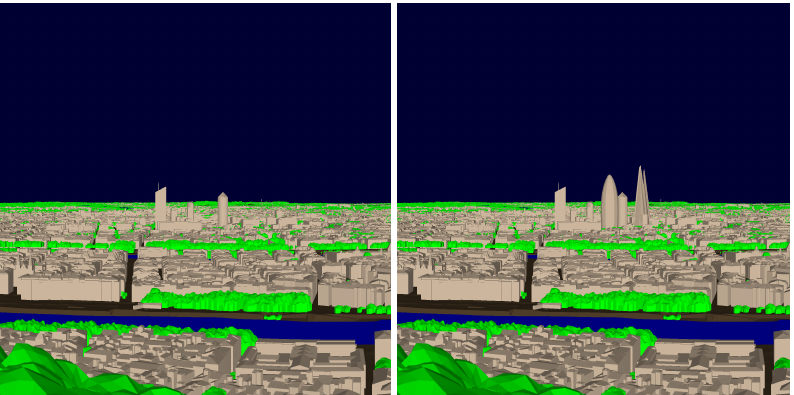
Figure 21. Visualization of an imaginary high-rise project (on the right) in the existing business district of La Part-Dieu from the belvedere of